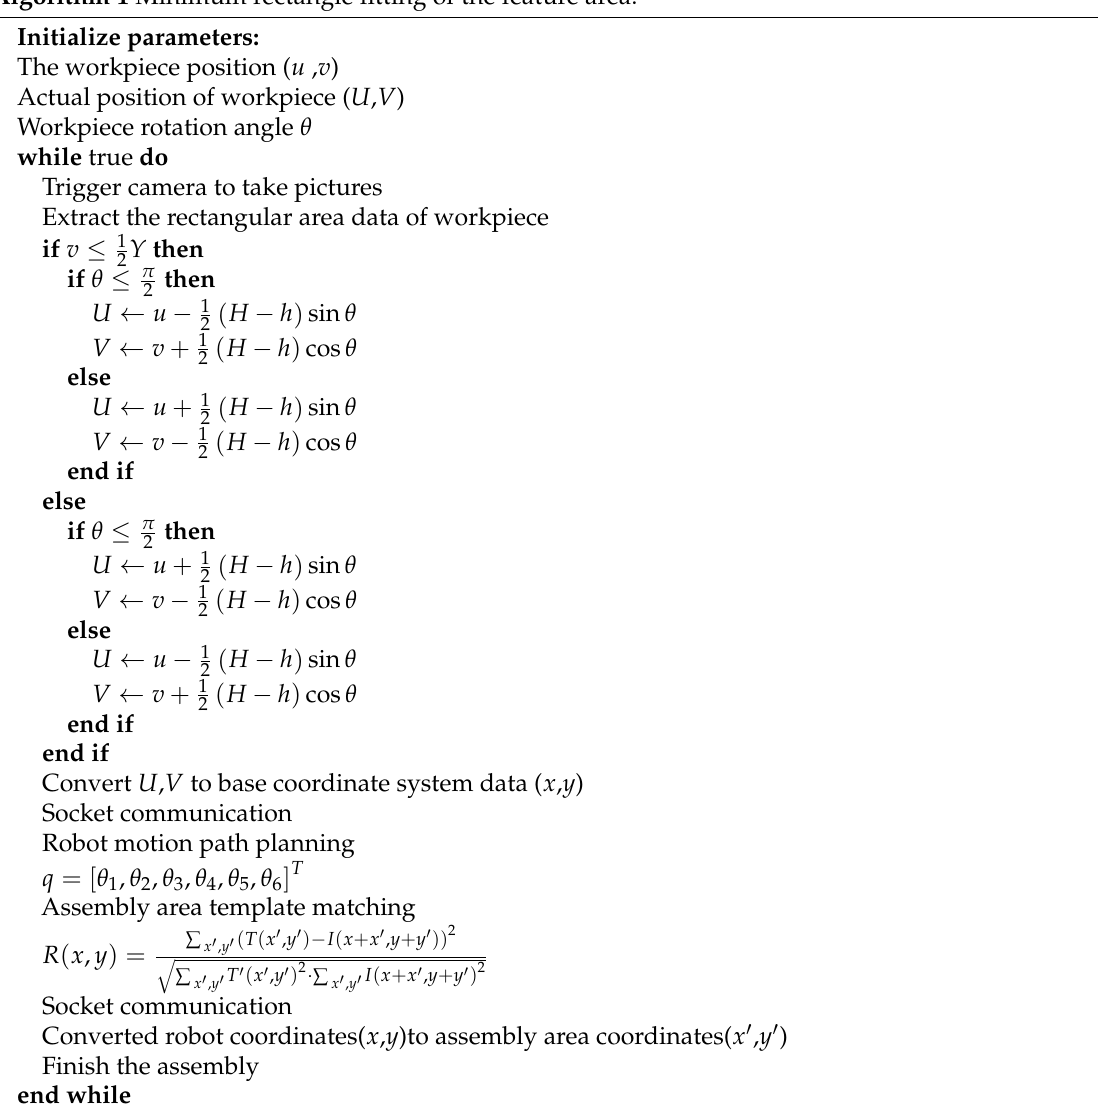
Algorithm 1 Minimum rectangle fitting of the feature